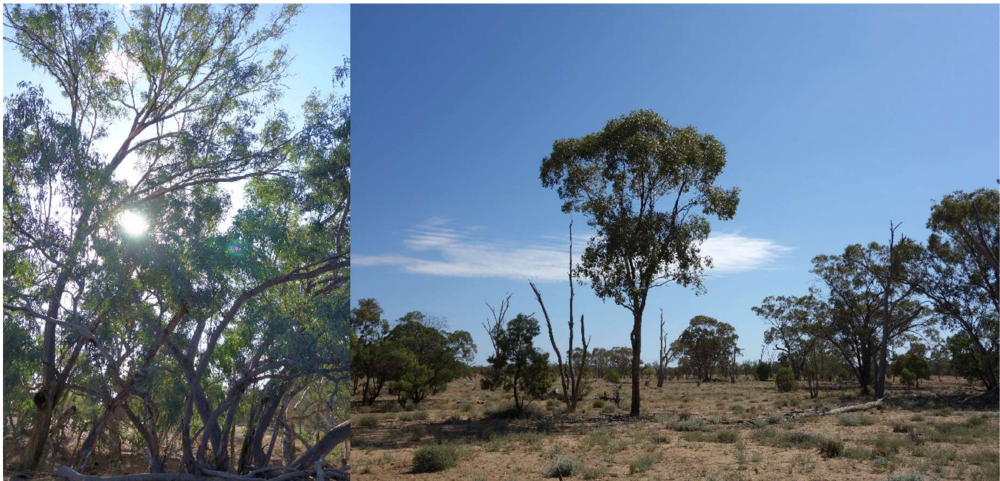
Figure 2. Field colour photos of Landscape A showing a riparian habitat dominated by Eucalyptus camaldulensis (left) and a floodplain habitat dominated by Eucalyptus populnea (right) in October 2015.